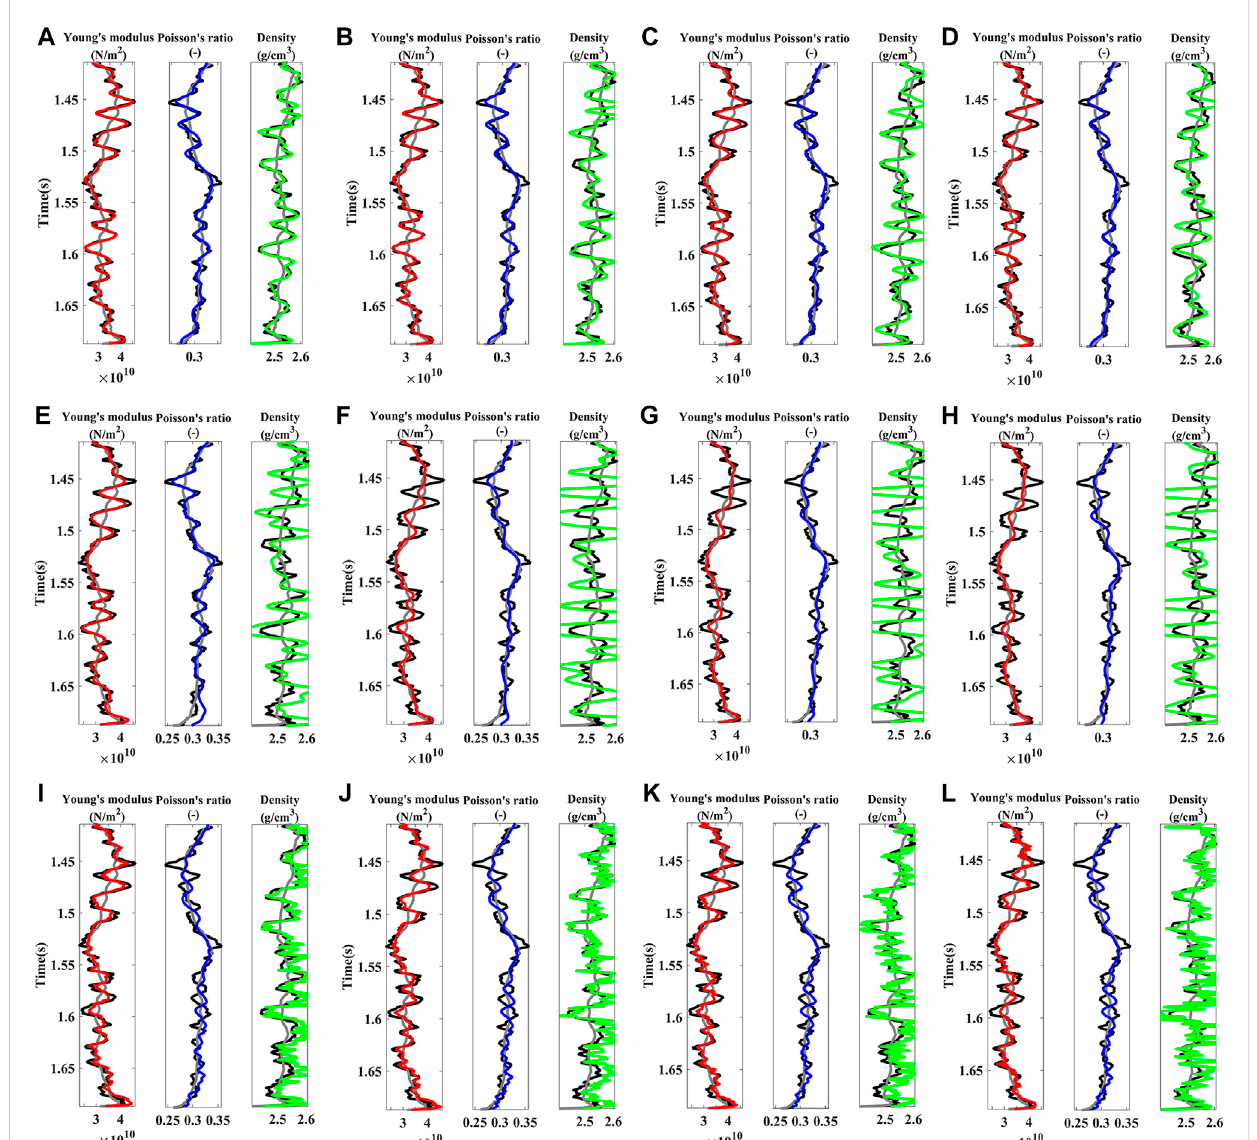
FIGURE 8 Comparison among thetruemodels (black), initial models(gray), and PPwave inversion results for Young ’ smodulus (red),Poisson ’ sratio(blue), and density(green)basedonthenewlyrewrittenZoeppritzequationwith (A) nonoise, (B) whitenoise(S/N=5), (C) whitenoise(S/N=2), (D) pinknoise(S/N= 2), and the YPD approximation with (E) no noise, (F) white noise (S/N = 5), (G) white noise (S/N = 2), (H) pink noise (S/N = 2), and the non-linear YPD equation with (I) no noise, (J) white noise (S/N = 5), (K) white noise (S/N = 2), (L) pink noise (S/N =